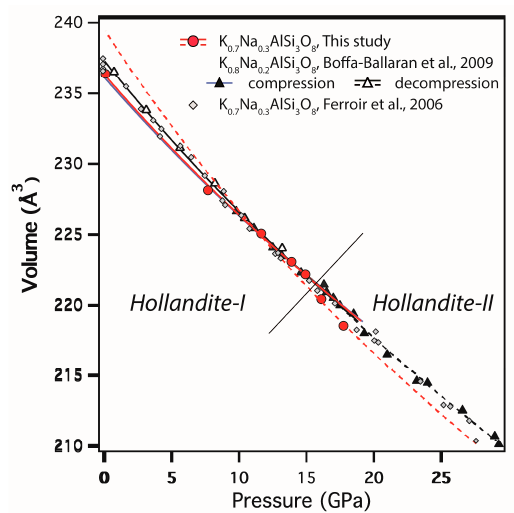
Figure 3. Unit-cell volume of K 0.7 Na 0.3 AlSi 3 O 8 liebermannite as a function of pressure across the hollandite-I to hollandite-II transition. Red lines represent a fitting of hollandite-I (solid line) and hollandite-II (broken line) data by a Birch–Murnaghan EoS (Equation (1)). Black lines represent a fitting of Boffa-Ballaran et al.'s [21] data with (solid line) and without (broken line) decompression data.